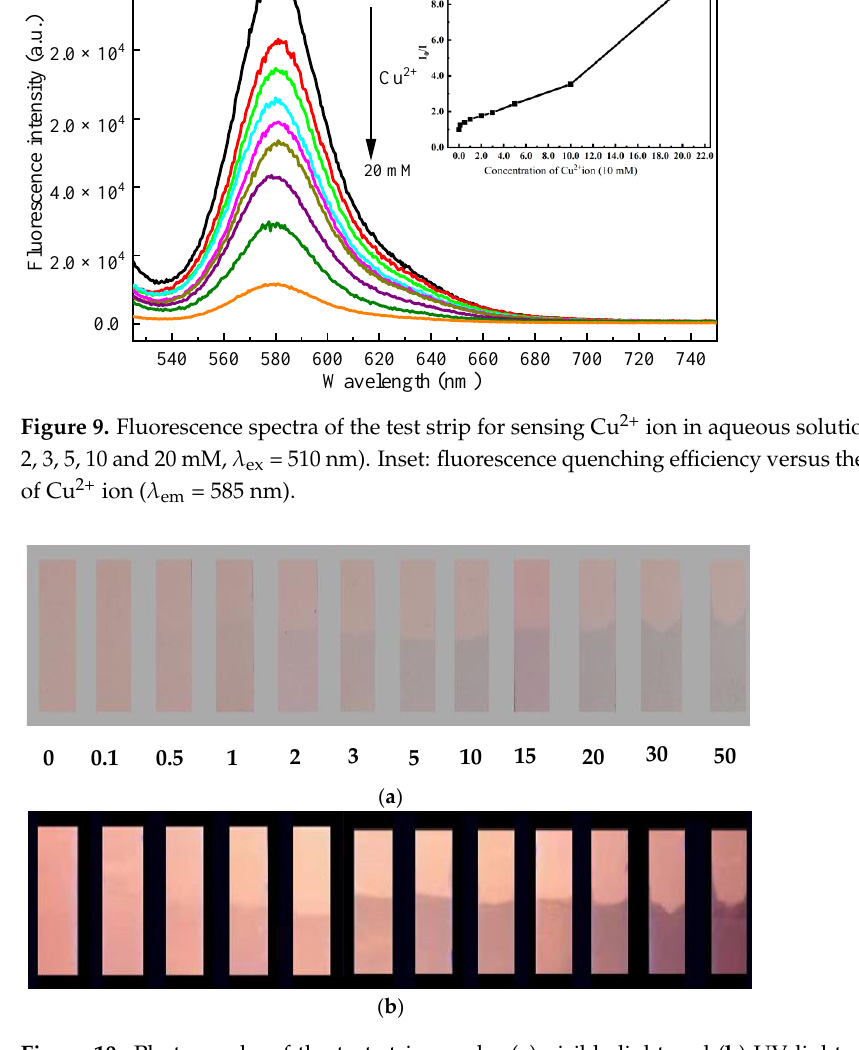
Figure 8. Fluorescence spectra of the test strip for sensing different metal cations (5 mM) in aqueous solution ( λ ex = 510 nm). Similar to sensing in solution, as the concentration of Cu 2+ ion increased, the emission intensity of the test strip decreased gradually (Figure 9). By increasing Cu 2+ concentrations (0 – 50 mM), the emission color of the test strips gradually became darker under visible light and as well under illumination of 365-nm UV lamp (Figure 10). However, by the naked eye the detection limit for color change was less than 0.1 mM of Cu 2+ ion.